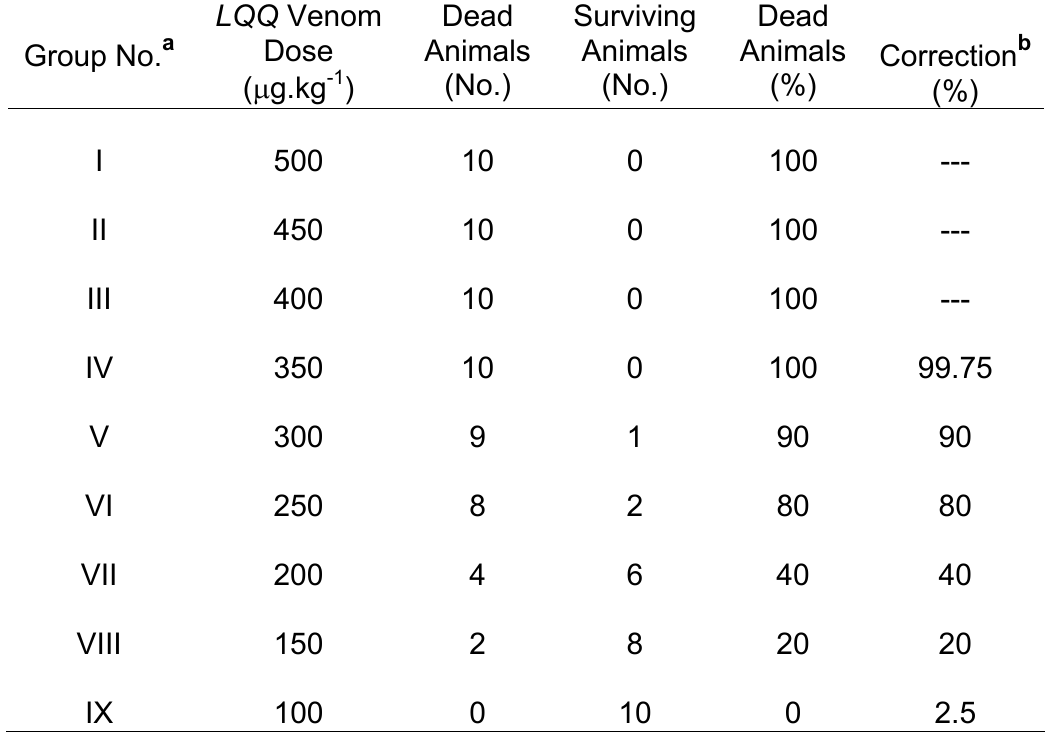
Table 2: Effect of different doses of LQQ venom, injected intravenously, on mice